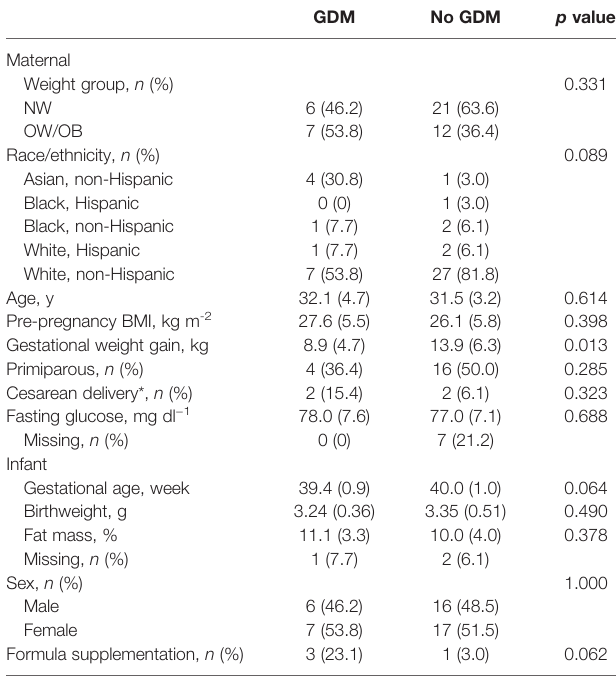
TABLE 1 | Maternal and infant characteristics strati fi ed by maternal GDM. GDM No